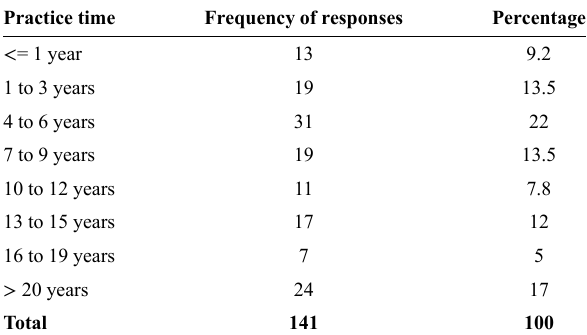
Table 1 - Practice time in years for the sample of athletes from the Fed- eral District of